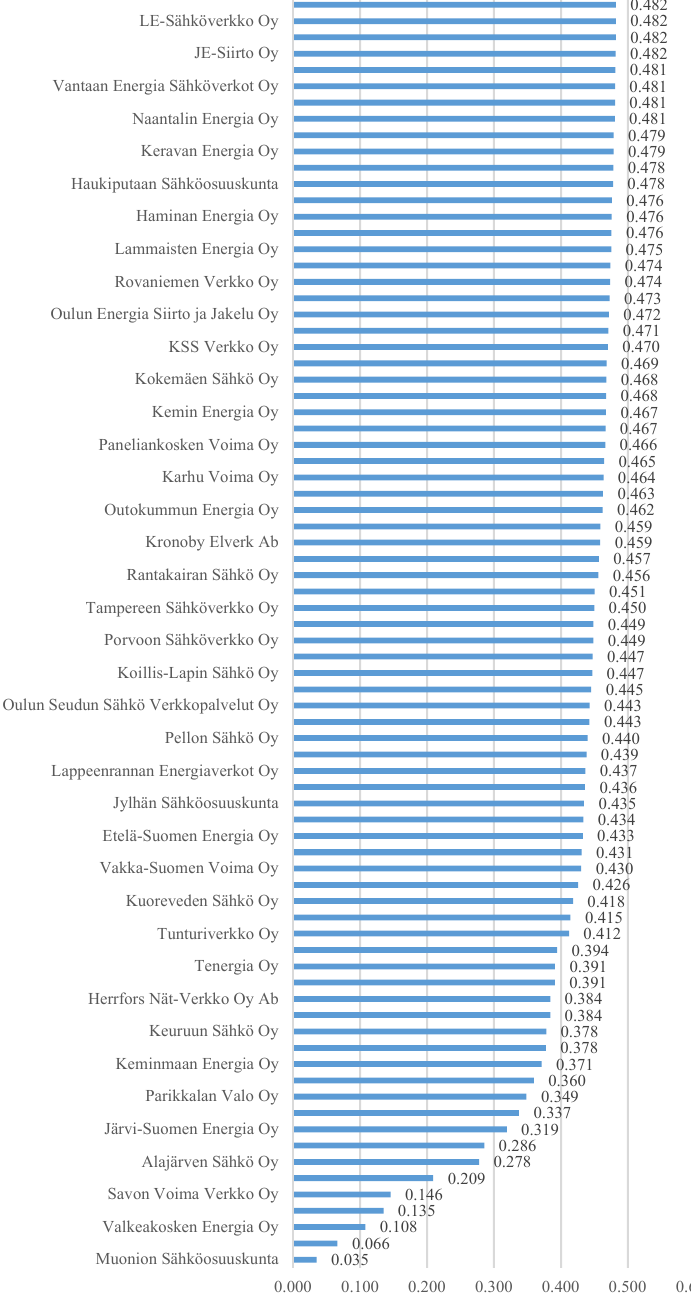
Figure 1. Shadow price (€ in cents) of one minute of interruption during 2015.